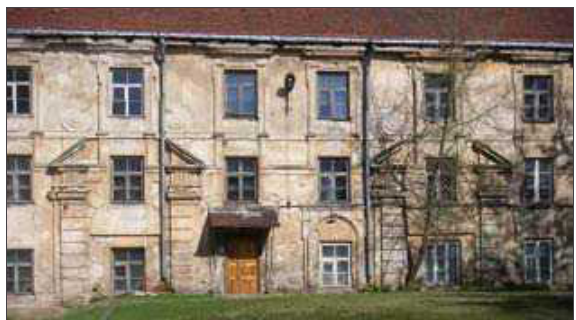
Fig. 2. r­emainder of Jonušas r­advila palace (Liejykla st